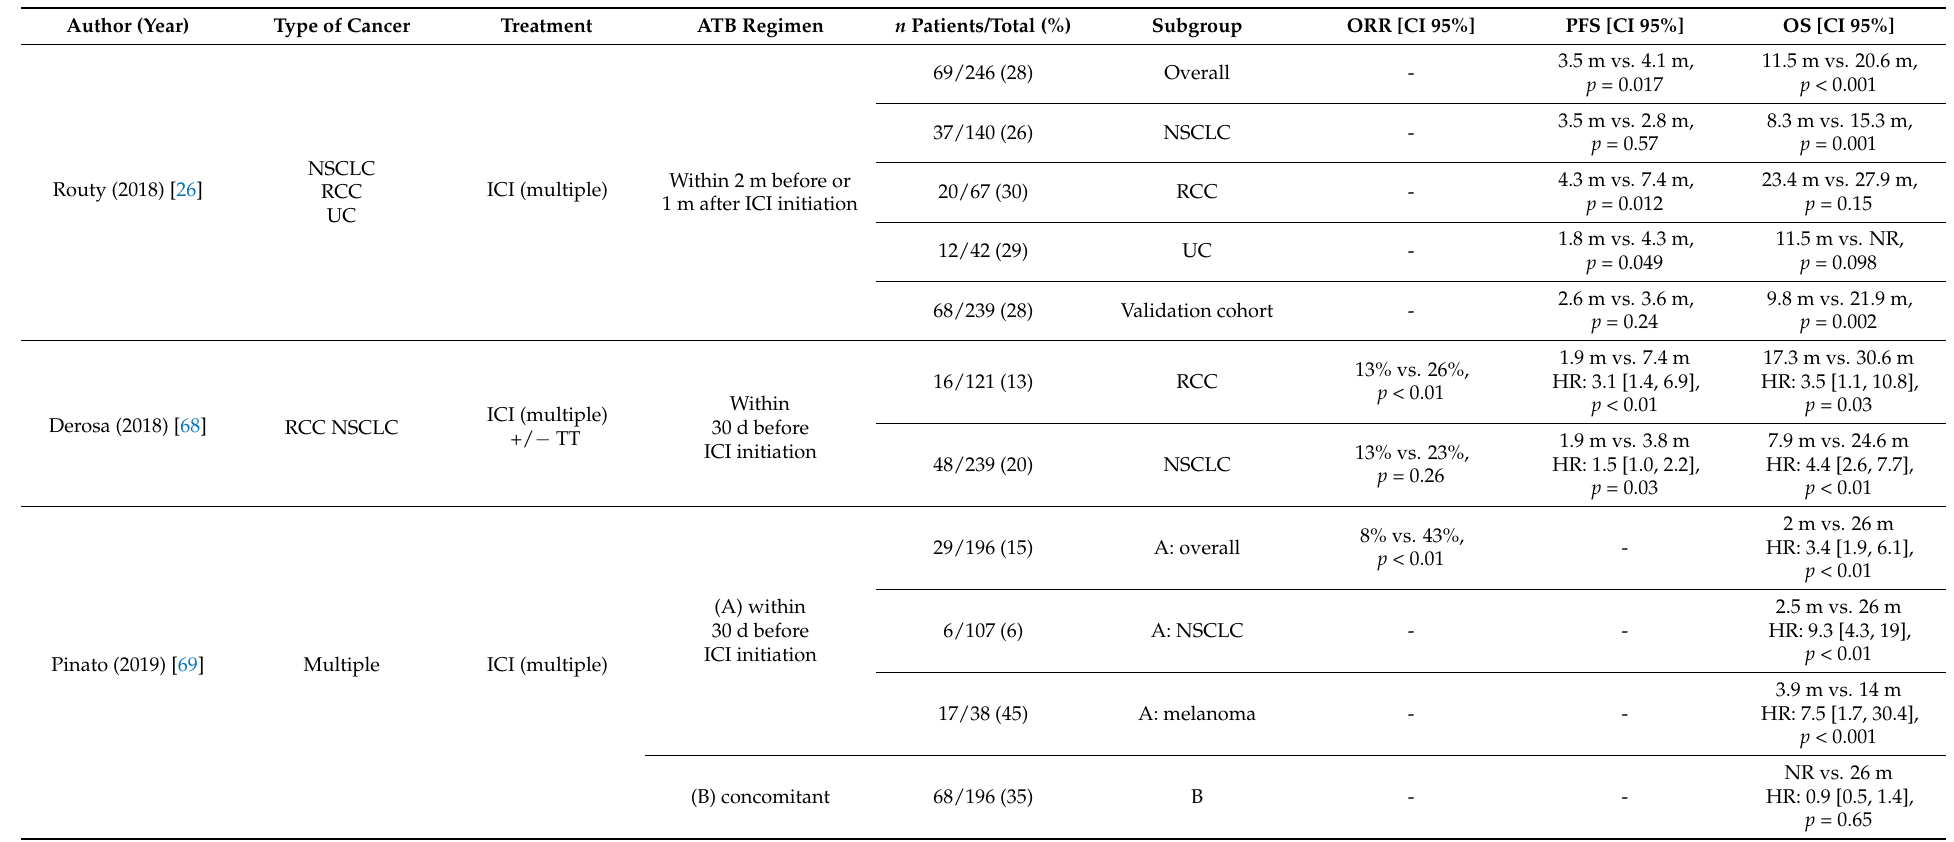
Table 3. Studies analyzing the impact of baseline and/or concomitant antibiotics on response rate and survival with ICI and/or chemotherapy or targeted therapy